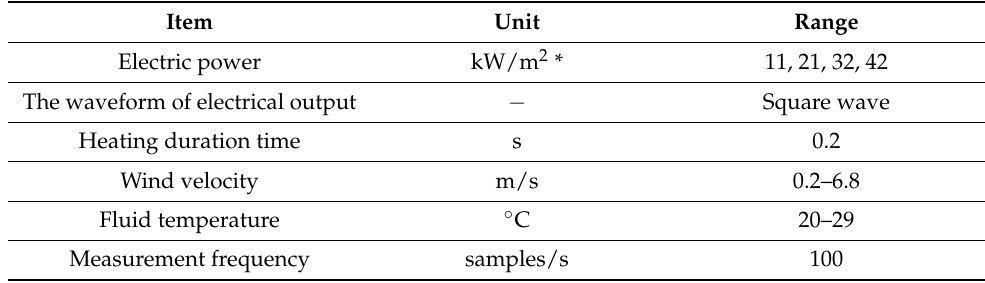
Figure 5. Velocity by optical fiber ( U OF ) against reference velocity ( U ref ). Table 1. Test parameters and their